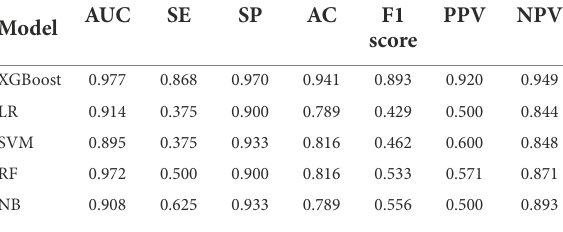
TABLE 2 Comparison of the predictive performance of different